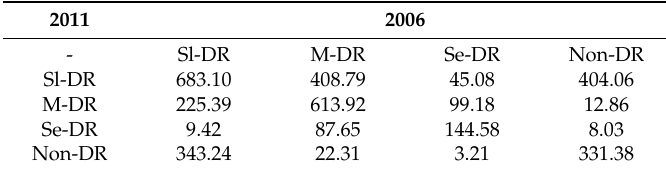
Table 7. Rangeland degradation changes (km 2 ) from 2006 to 2011 in Linxia rangeland.